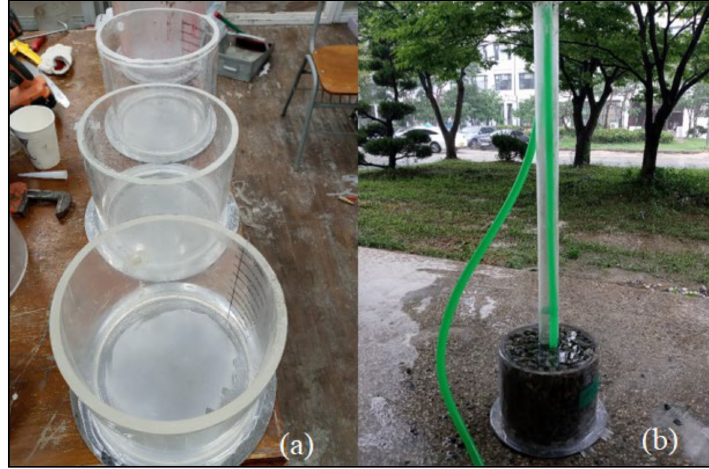
Figure 10. ( a ) Molds and ( b ) aggregate and water-filled mold. Two samples of each grout type were prepared: one with the jointed rock permeability fine aggregate (10-mm) and the other with the open-jointed rock permeability coarse aggregate (16-mm). Thus, a total of 18 samples were prepared. After seven days of curing, the samples were dried, and a permeability test was performed. Each sample was placed underwater for one day at a maximum pressure of 1 MPa. Typically, pressure is maintained at 0.5 MPa, but it was increased to 1 MPa to reduce the test time from two days to one. Following a test as per the British standard BSEN 12390 [14], the maximum depth of the water penetration traces was measured. A sample of each grout mix was drilled, and two cylinders of each sample with fine and coarse aggregates were created using a rotary drill. A total of 36 samples were extracted, as depicted in Figure